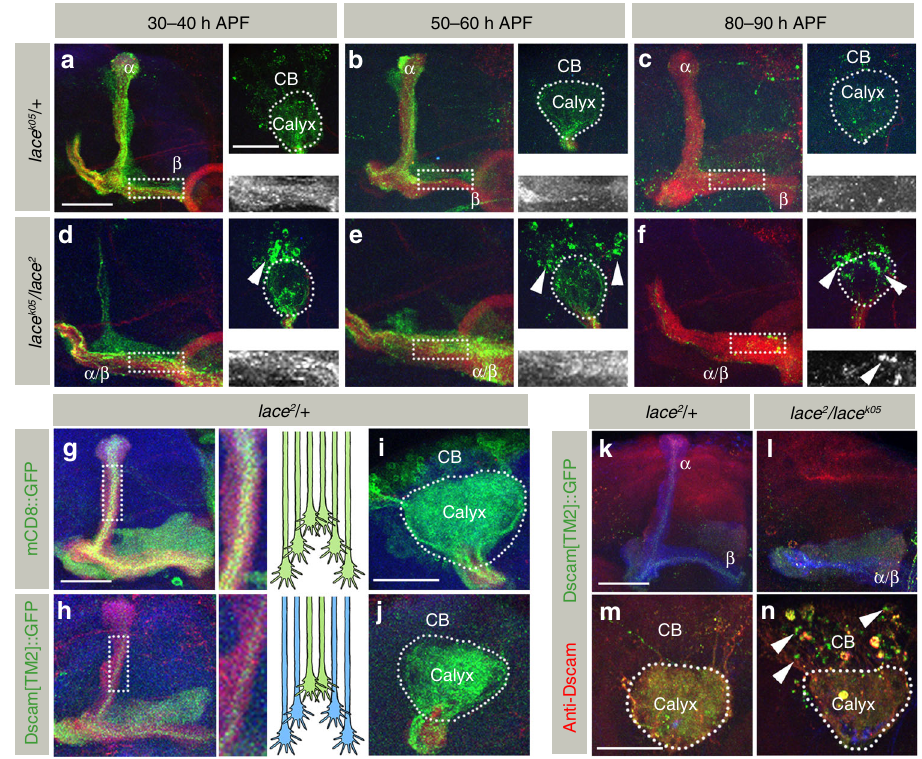
Fig. 9 Dscam aggregates in SPT mutants escape protein degradation. a – f Distribution of Dscam[TM2]::GFP in lace k05 / + ( a – c ) and lace 2 /lace k05 ( d – f ) at different stages of pupal development, 30 – 40h ( a , d ), 50 – 60h ( b , e ), and 80 – 90h ( c , f ) expressed using Rubin Gal4 ( R30F11-Gal4) . While images a – f represent the axonal half of the MB, the corresponding somato-dendritic area is represented in right upper insets. The white dotted rectangle represents Dscam [TM2]::GFP distribution in the axons, zoomed in and shown in the right lower inset. In lace k05 / + expression of Dscam[TM2] using R30F11-Gal4 starts to decline by 50 – 60h APF ( e ) and is nearly not detectable at 80 – 90h APF ( f ). On the other hand, lace k05 /lace 2 shows formation of aggregates by 30 – 40h APF (( d ), arrowhead), which grow by 50 – 60h APF (( e ), arrowheads) and are stable later in the development (80 – 90h APF, ( f ), arrowhead), although membranous Dscam[TM2] is degraded. n ( a ) = 14, n ( b ) = 22, n ( c ) = 12, n ( d ) = 8, n ( e ) = 8, n ( f ) = 10. Green: Dscam[TM2]::GFP, Red: FasII, Blue: N-Cad. Arrowheads indicate somatic aggregates of Dscam[TM2]::GFP. g – j The relatively fast turn-over dynamics of Dscam[TM2] is also evident when comparing the axonal distribution of mCD8::GFP ( g , i ) with Dscam[TM2]::GFP ( h , j ). Dscam[TM2]::GFP shows much restricted distribution in terms of expression in newly developed neurons (201Y-Gal4) when compared to membranous marker mCD8::GFP. The white dotted rectangle represents the axonal area zoomed in the inset. Green: mCD8::GFP, Red: FasII, Blue: N-Cad. k – n The Dscam[TM2] aggregates are only partially recognized by the Dscam antibody (( n ), arrowheads), in contrast to